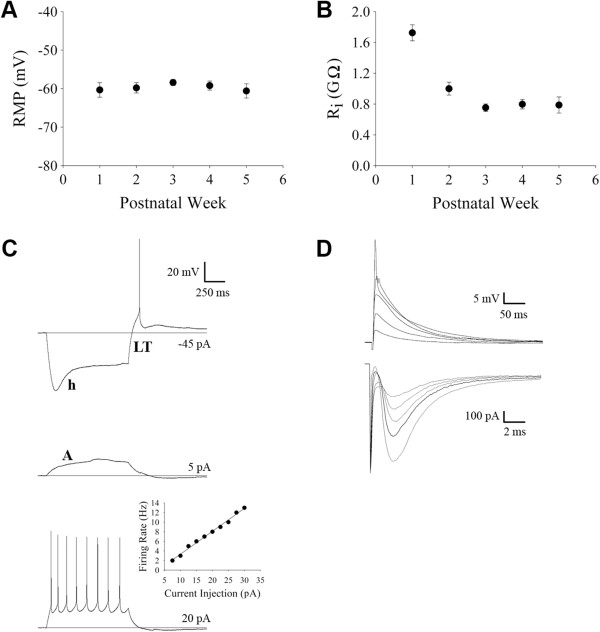
Functional and morphological properties of green fluorescent protein (GFP) expressing interneurons in dorsal lateral geniculate nucleus (dLGN). (A,B) Plots showing the resting membrane potential (RMP; (A)) and input resistance (Ri; (B)) for a total of 72 interneurons recorded at different postnatal weeks (week 1, n = 6 cells, 1 slice; week 2, n = 15 cells, 10 slices; week 3, n = 27 cells, 14 slices; week 4, n = 14 cells, 4 slices; week 5, n = 10 cells, 2 slices). (C) Examples of voltage responses to varying current injection (indicated on the far right) at P10. The letters next to the traces correspond to some of the more salient active membrane properties of interneurons (h, hyperpolarization activated mixed cation conductance; LT, rebound low threshold Ca2+ spike; A, slow outward rectifying K+ conductance). The inset shows the linear relationship between spike frequency and current injection for responses in (C). (D) Example of excitatory postsynaptic responses recorded at −65 mV in current (top, excitatory postsynaptic potentials (EPSPs)) or voltage clamp (bottom, excitatory postsynaptic currents (EPSCs)) of a P14 interneuron evoked by increasing levels of electrical stimulation (40, 45, 50, 55, and 60 μA).